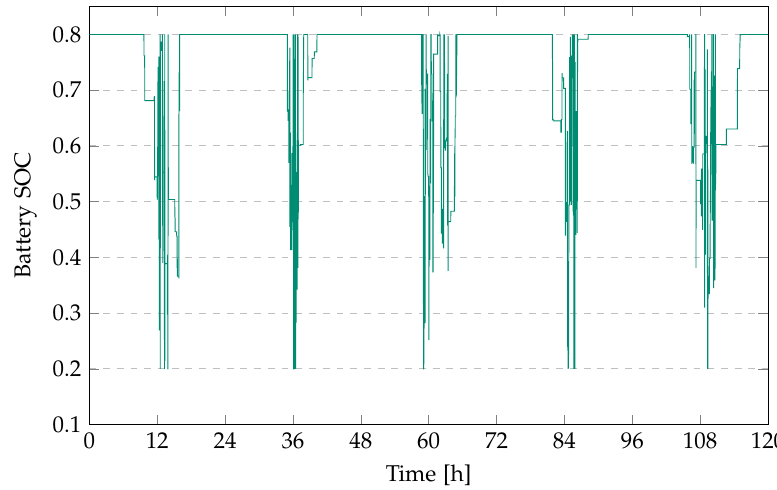
Figure 5. The battery SoC for a 13.5-kWh battery over a period of five days.